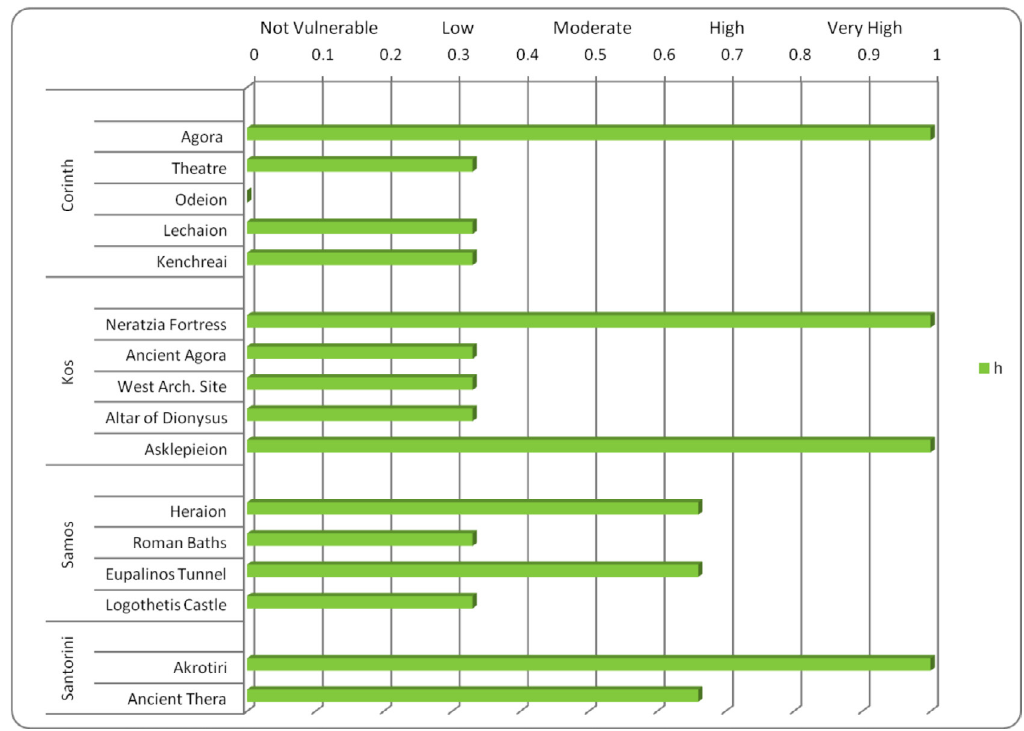
Figure 9. The human vulnerability indicator for the archaeological sites under